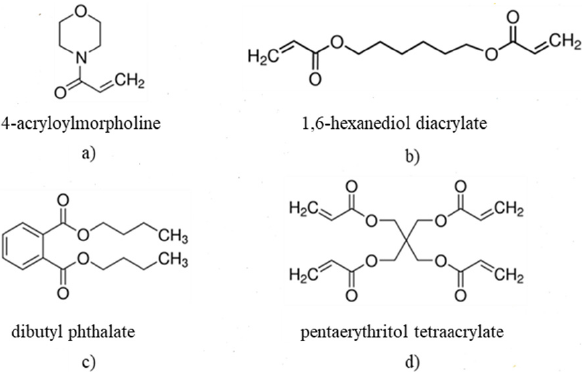
Figure 2. Chemical structure of the resin components: ( a ) 4-acryloylmorpholine; ( b ) 1,6-hexanediol diacrylate; ( c ) dibutyl phthalate; ( d ) pentaerythritol tetraacrylate.